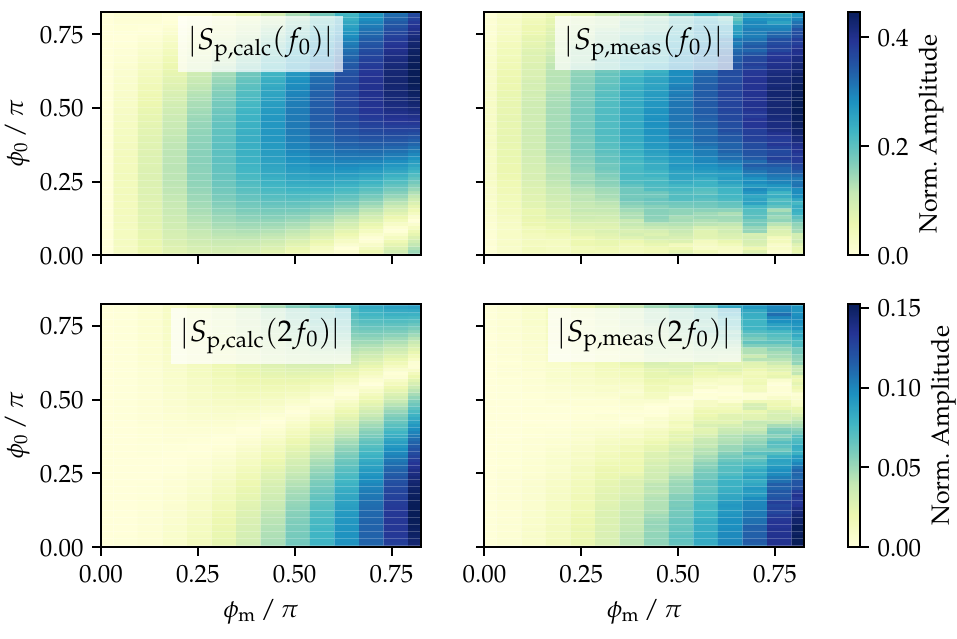
Figure 6. Signal power of fundamental f 0 and first harmonic 2 f 0